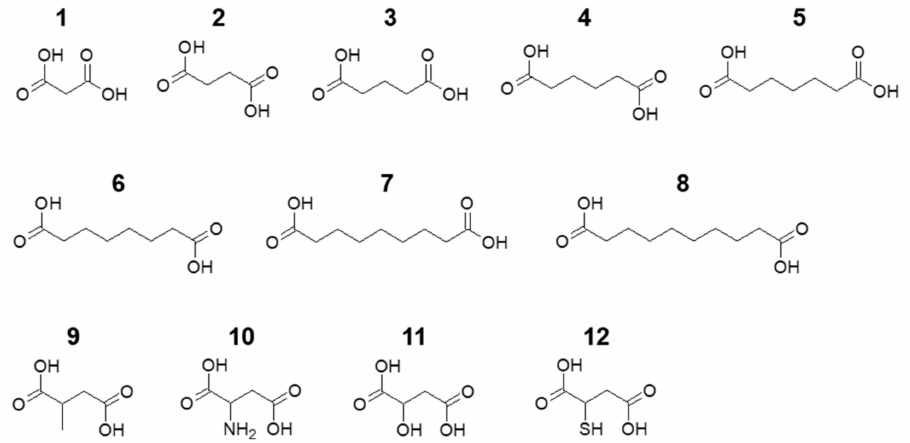
Figure 1. Molecular structures of the aliphatic dicarboxylic acids (1–8) and succinic acid derivatives (9–12) studied in this work: 1, malonic acid; 2, succinic acid; 3, glutaric acid; 4, adipic acid; 5, pimelic acid; 6, suberic acid; 7, azelaic acid; 8, sebacic acid; 9, methylsuccinic acid; 10, aspartic acid; 11, malic acid; 12, mercaptosuccinic